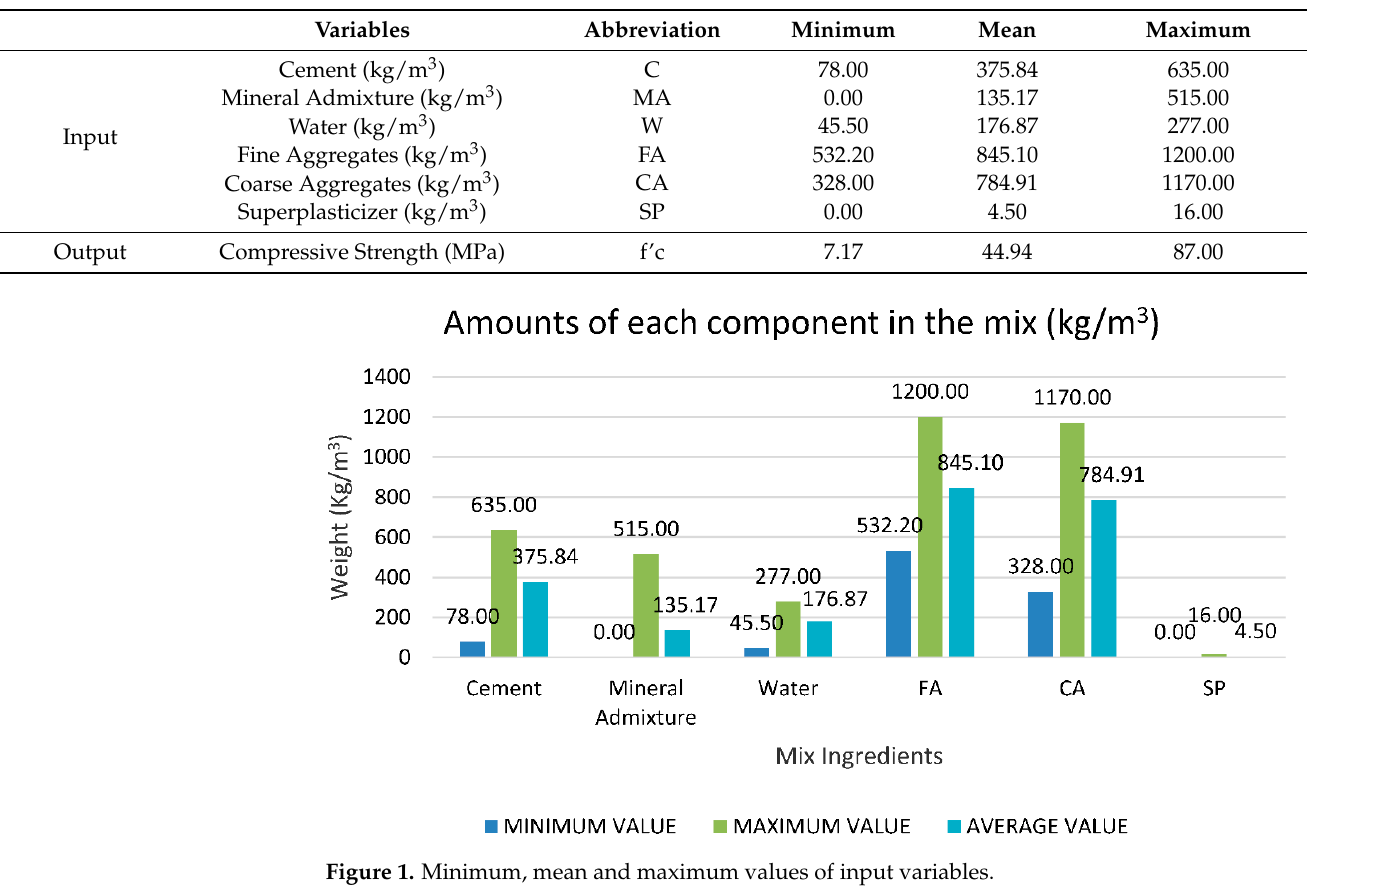
Table 2. Minimum, Mean, and Maximum values of the input and output variables.